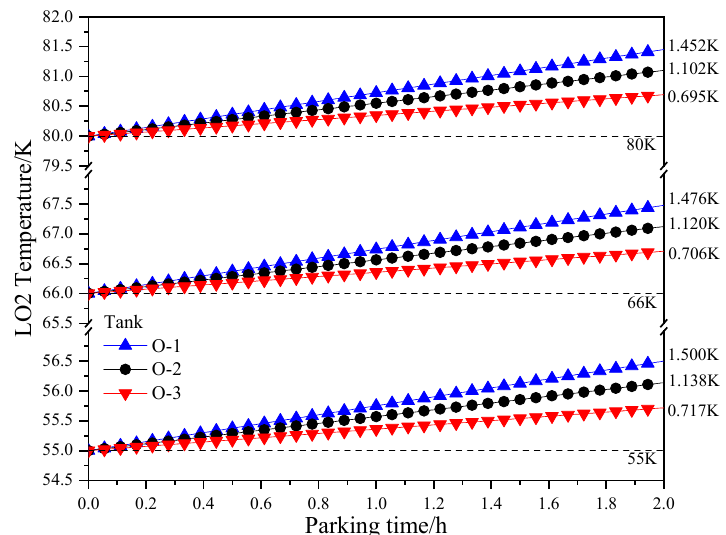
Figure 3. Temperature rise of densified LO2